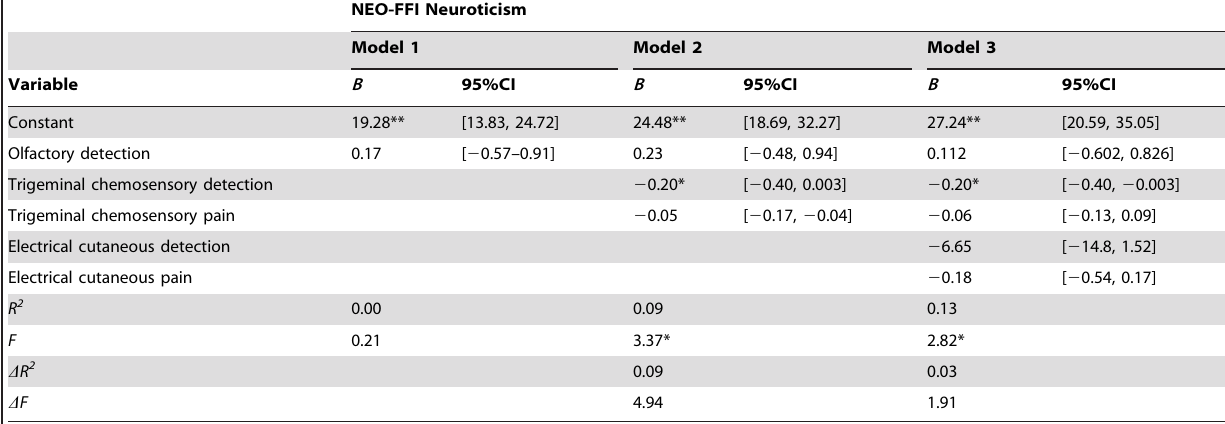
Table 4. Predictors of